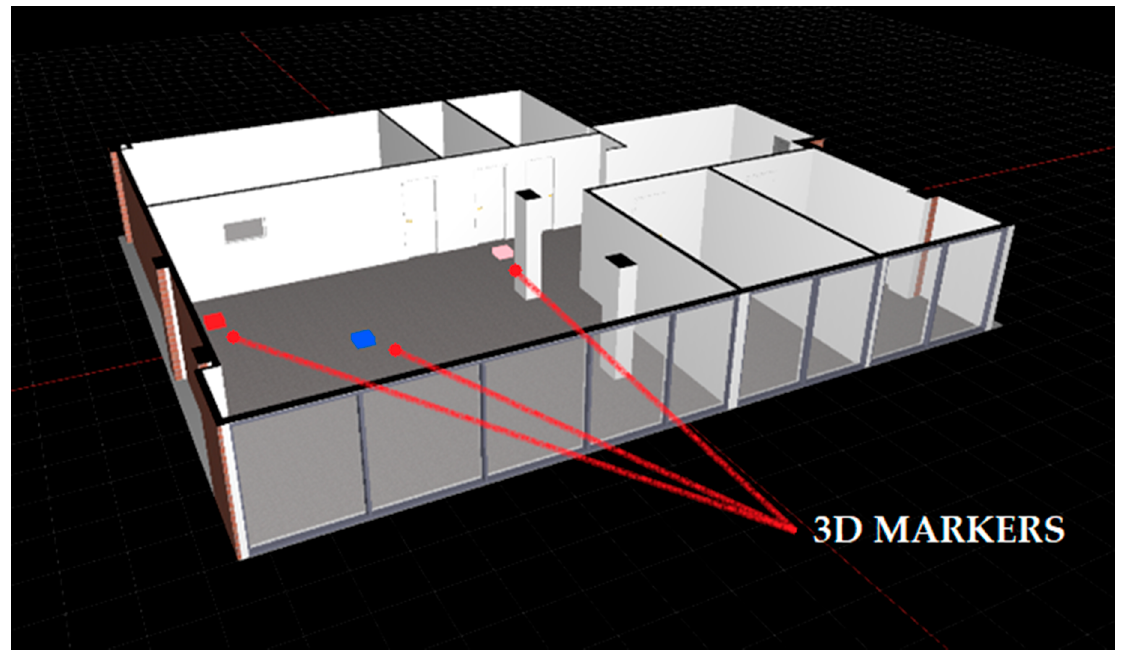
Figure 22. The panel of the presence detection system with 3D visualizations of the building, including colored markers of detected people, designed by CBRTI Sp. z o.o. Research and Development Center.